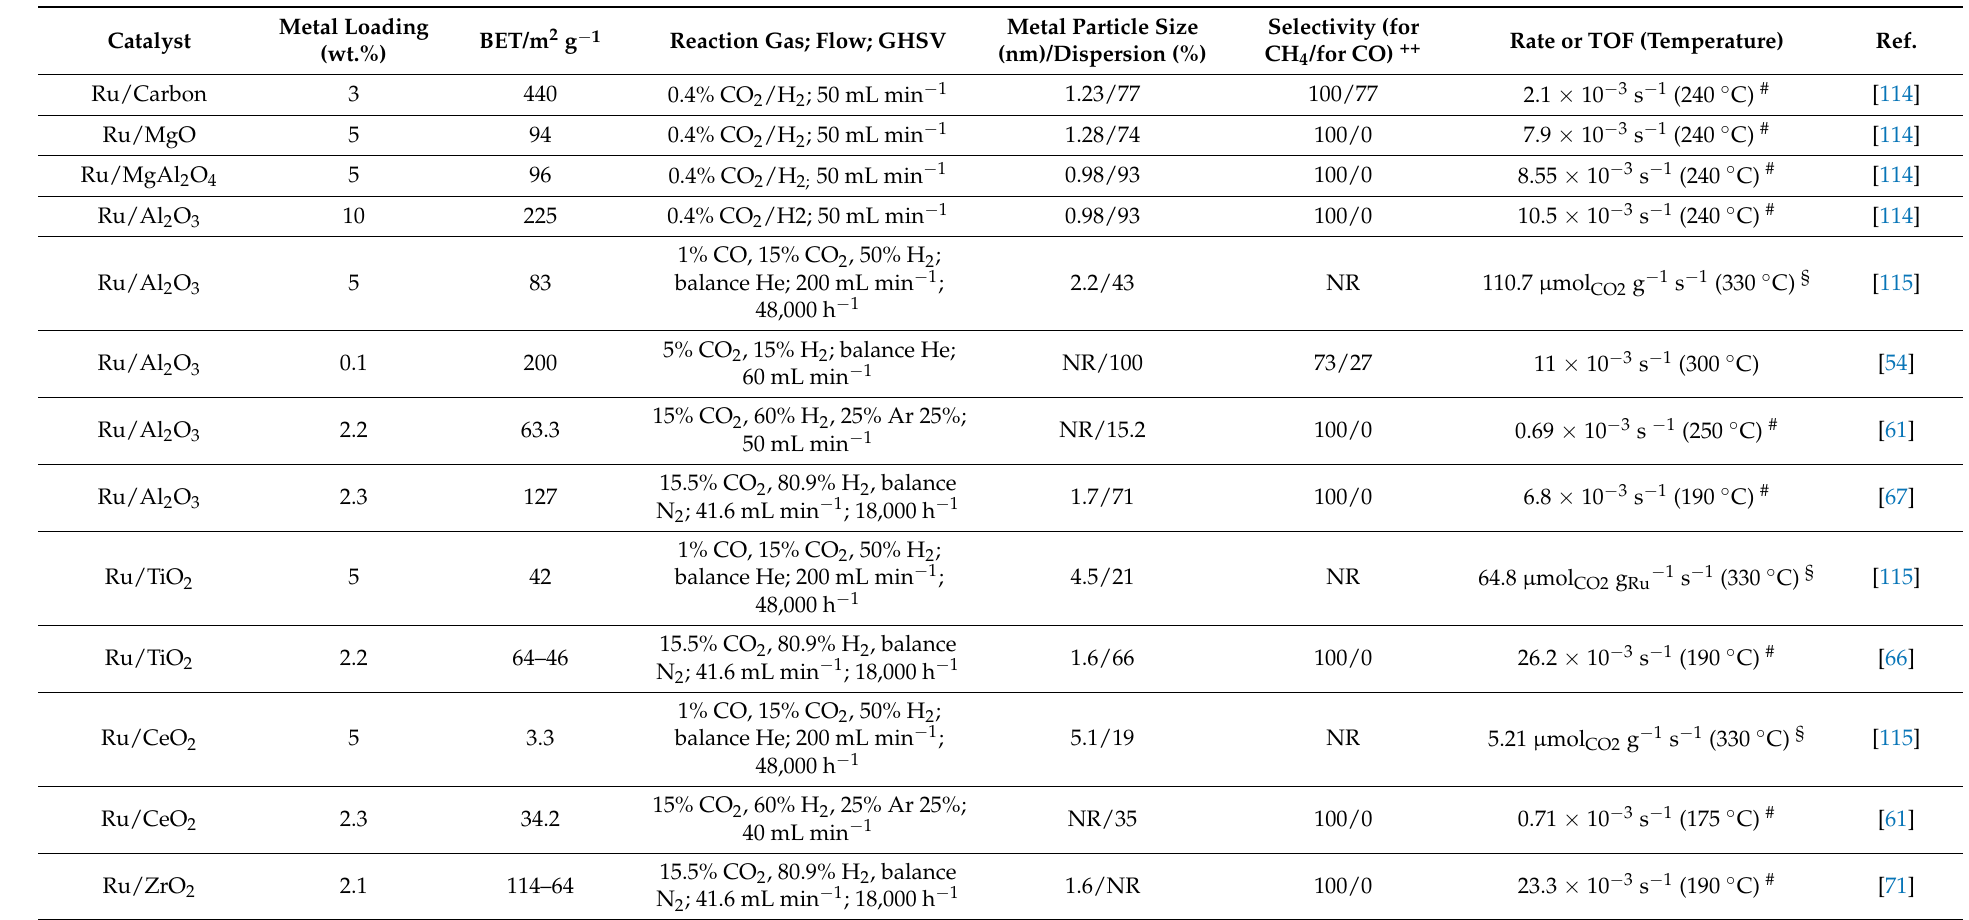
Table 1. Comparison of structural parameters of supported metal catalysts and their catalytic